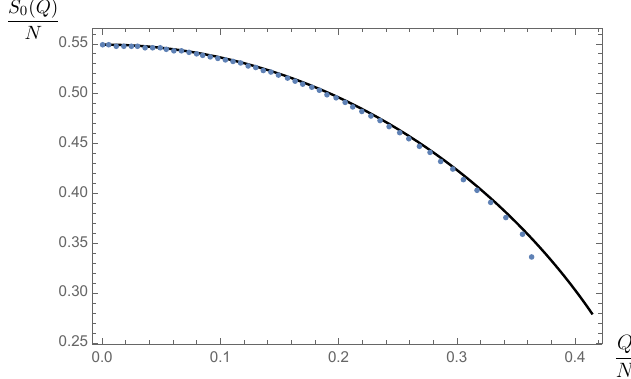
Figure 12 . Plot showing the zero temperature entropy for q = 3 N = 2 SYK, computed using the spooky fermion and boson propagators in equation (2.90) (solid black line) as a function of charge from Q = 0 up to the critical value Q = 0 . 4142 N . We also show the result from a numerical solution of the Schwinger-Dyson equations (blue dots) showing perfect agreement, at least far enough from the critical charge where the numerical procedure becomes more